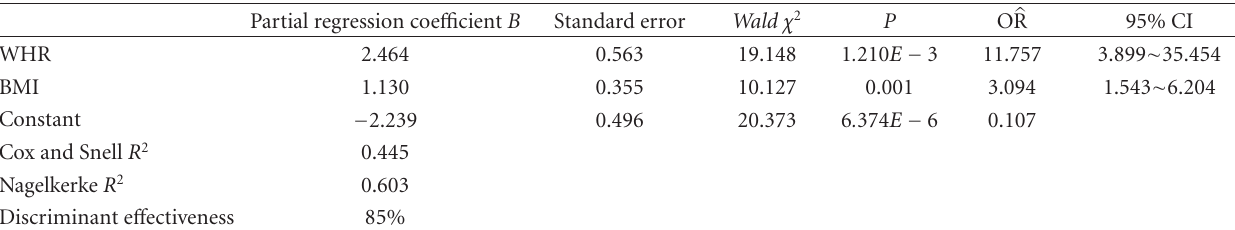
Table 6: Logistic analysis of risk factors of NAFLD.